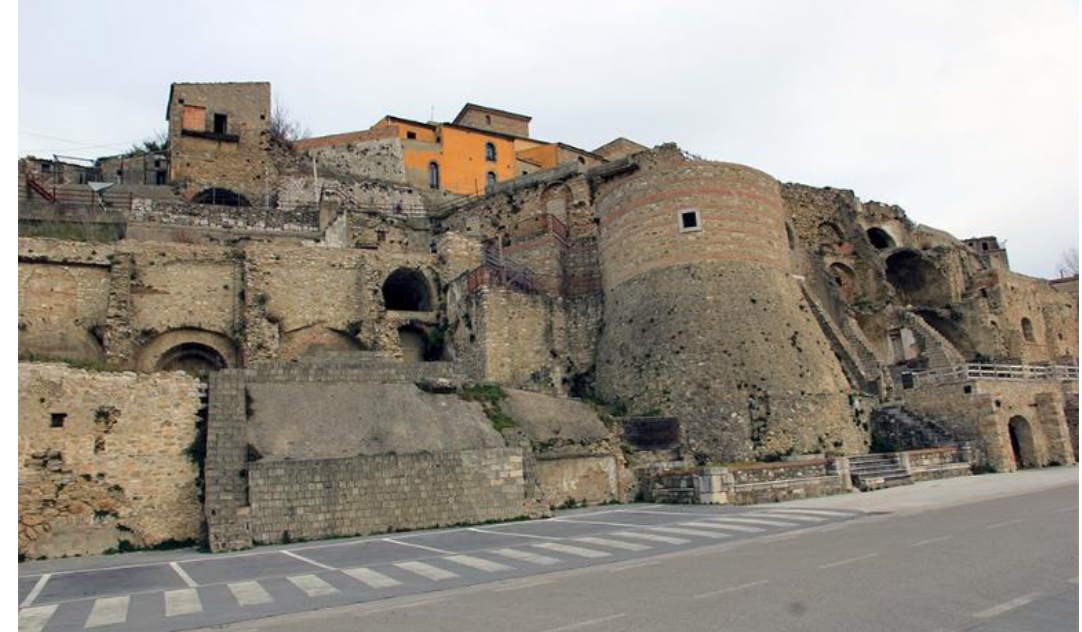
Figure 112. Calitri: historical centre, remains of some buildings that were recovered after the 1980 earthquake (photos by [35,36]).